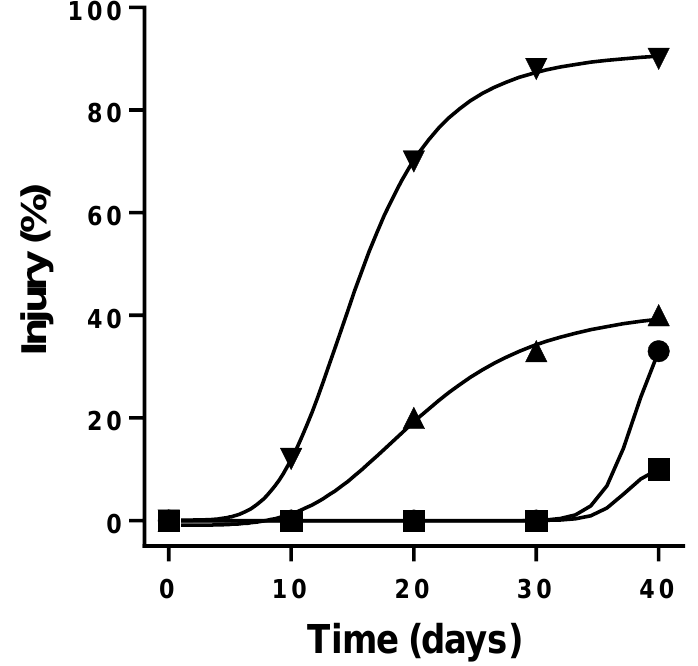
Figure 1. Injury rating curve (%) of different concentrations of smoke water in D. insularis . • = 0%, (cid:4) = 5%, (cid:78) = 10%, and (cid:72) = 20%. Linear regression was used to analyze data from the time–injury curve. These data were analyzed using R statistical package (Release 4.2.2).